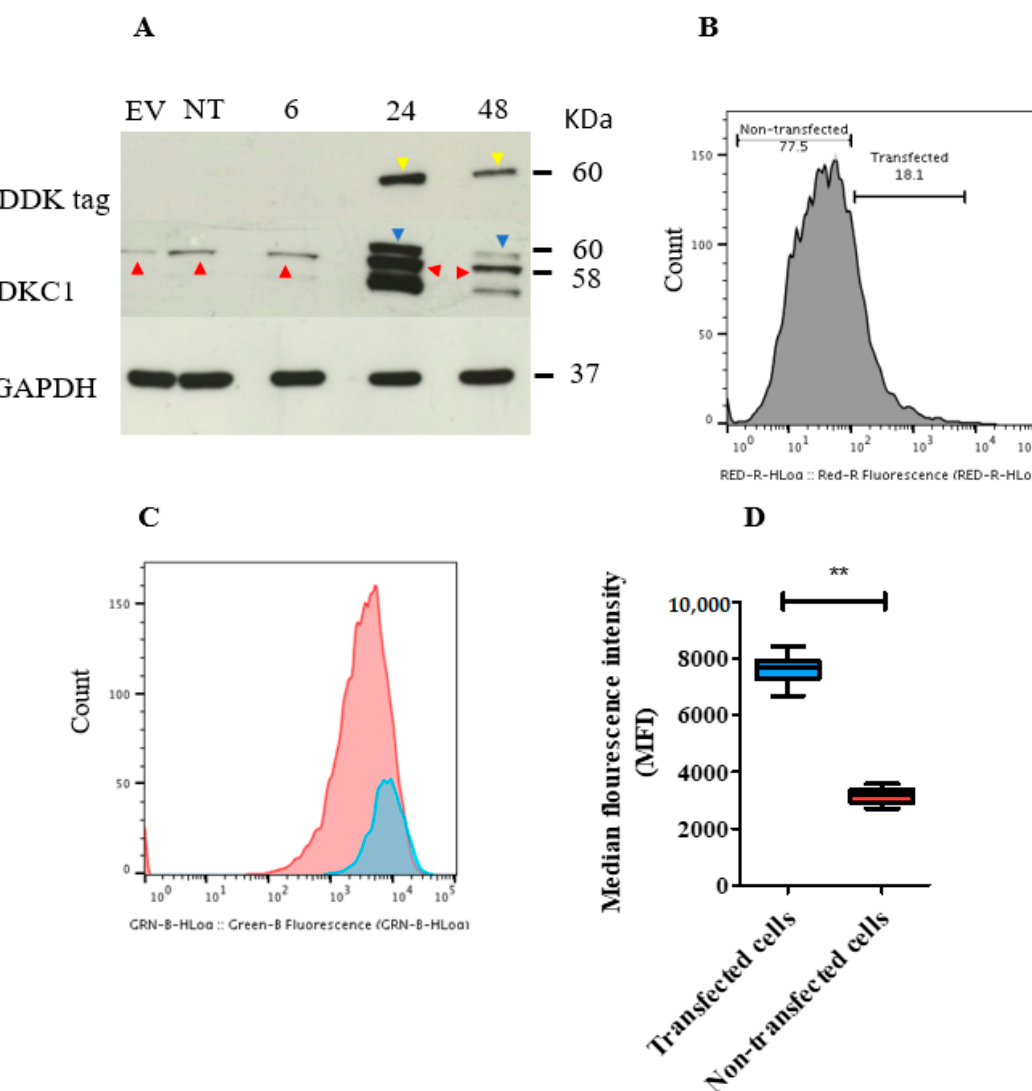
Figure 6. Transient overexpression of DKC1 in ISK cells. The plasmid and the empty vector (EV) used were tagged with the synthetic DYKDDDDK (DDK) protein to discern the transfected cells by using an anti-DDK antibody. ( A ) Immunoblot showing the level of dyskerin protein in DKC1 and EV transfected and non-transfected (NT) ISK cells. Cells were harvested 6, 24, and 48 h following transfection. Endogenous and exogenous dyskerin bands were present at the molecular weight of 58 and 60 KDa (red and blue arrows, respectively). DDK bands (yellow arrows) were observed at 60 KDa. Glyceraldehyde 3-Phosphate Dehydrogenase (GAPDH) bands were at 37 KDa. ( B ) Flow cytometric histogram showing the level of DDK tag protein in ISK cells. Cells positively stained with anti-DDK tag antibody represent transfected cells. ( C ) Cell proliferation was analysed using flow cytometry. ISK cells were stained with CellTrace Carboxyfluorescein Diacetate Succinimidyl Ester (CFSE) and fluorochrome-conjugated DDK Tag Antibody. Transfected cells (blue curve) and non-transfected cells (red curve). Higher proliferation is suggested when the curve was shifted to the left. ( D ) The difference in median fluorescence index (MFI) between transfected (T) and non-transfected ISK cells. ** p < 0.01, Wilcoxon signed-rank